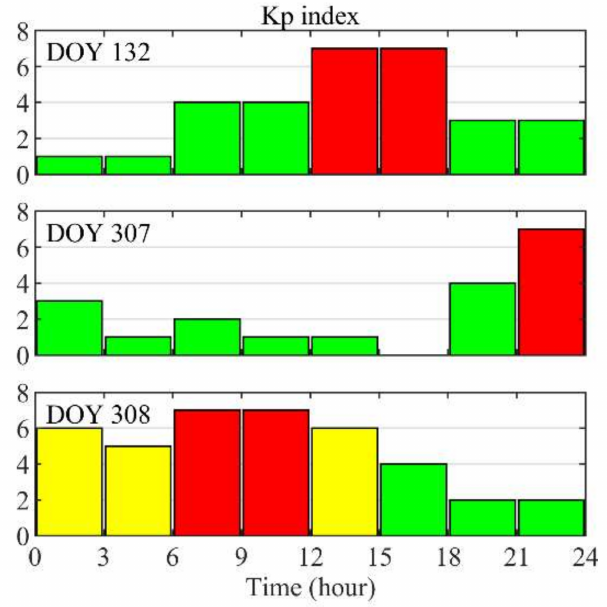
Figure 4. Kp index during strong geomagnetic storms. Red bars indicate Kp = 7, yellow bars indicate 5 ≤ Kp < 6, and green bars indicate Kp <